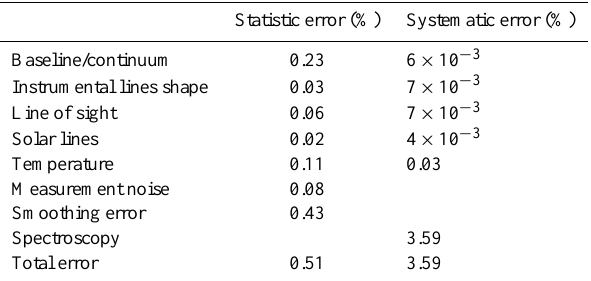
Table 3. Errors for each parameter for the scaling retrieval for CH 4 total column.